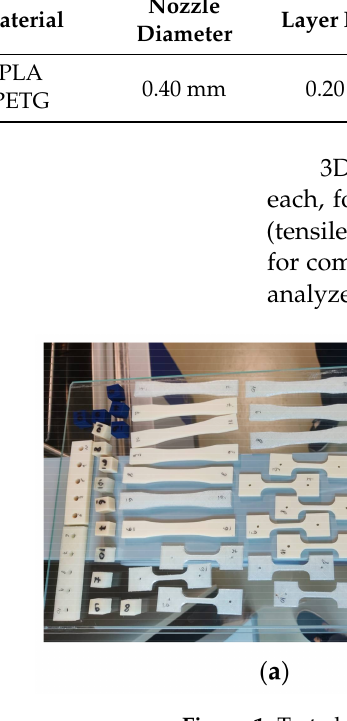
Figure 1. Tested materials: ( a ) 3D-printed parts; ( b ) UV-B exposure of tested group. Parts in the treatment group were subjected to UV-B irradiation, 310 nm